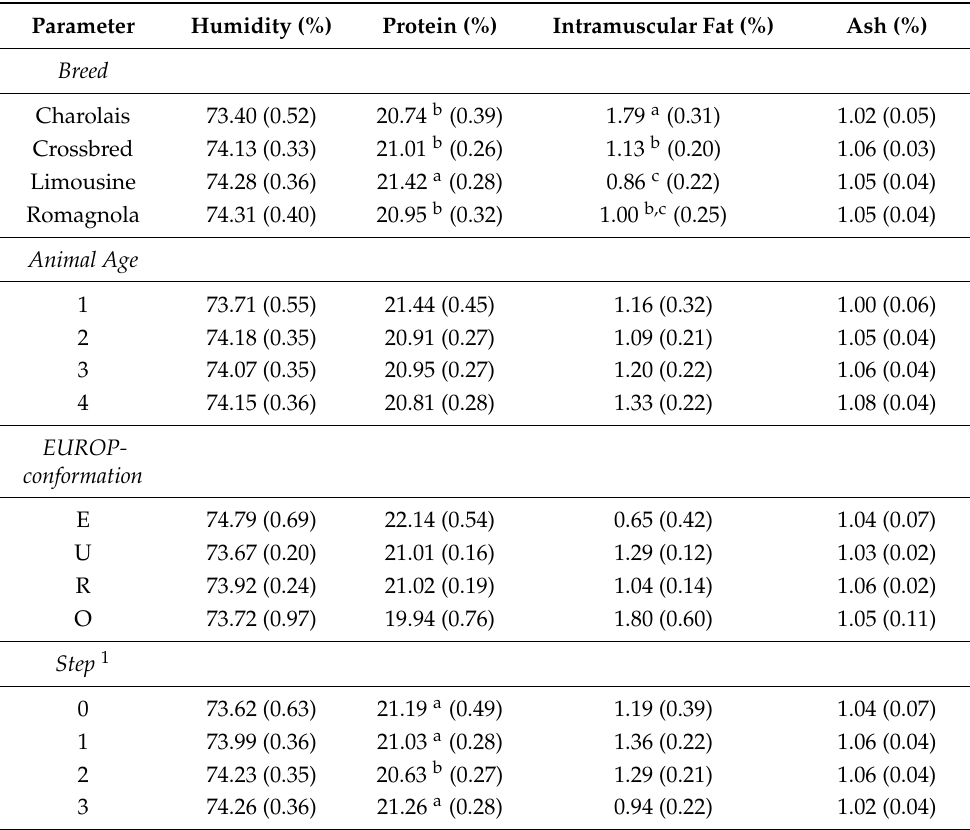
Table 2. Least squares means (SE in parentheses) of humidity, protein, intramuscular fat, and ash in samples before wet